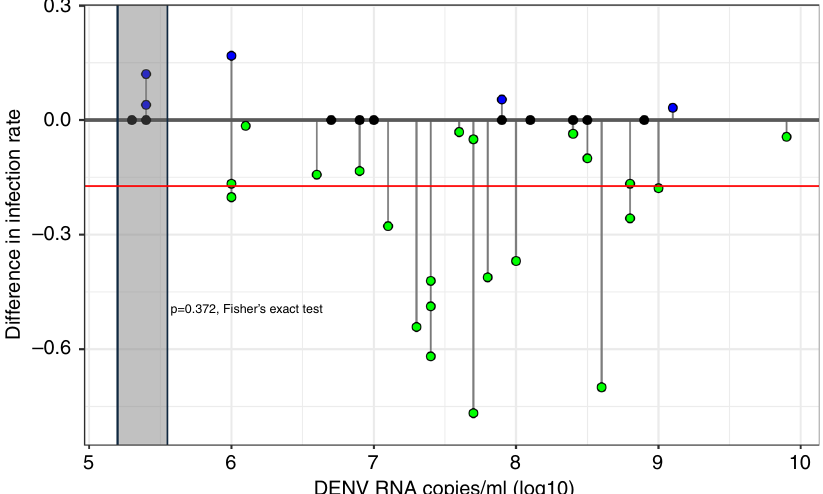
Fig. 2 Differences in abdomen infection rate [(rate in w Mel) — (rate in Wolbachia -uninfected)] between w Mel and Wolbachia -negative mosquitoes fed on viremic blood, replotted from the original Ferguson et al. 5 data. Each dot represents a feeding on blood sourced from a different dengue-infected patient. Negative differences (green dots) indicate a lower abdomen infection rate in w Mel-carrying mosquitoes. Positive differences (blue dots) indicate a higher abdomen infection rate in w Mel-carrying mosquitoes. Black dots indicate no difference. The red line shows the mean difference across all DENV titres. Shaded area shows data points in the 10 5 ≤ X < 10 6 RNA copies/ml stratum and statistical mosquito susceptibility to infection to a factor of 1.5 ” relative to Wolbachia -negative controls. However, the value is misleading. Replotting the Ferguson et al. 5 abdomen infection rates (Fig. 2) shows that in 23 out of 42 feedings or 54.7% (38.67 – 70.2%), w Mel-carrying mosquitoes displayed a lower infection pro- portion than Wolbachia -negative controls; in 14 out of 42 or